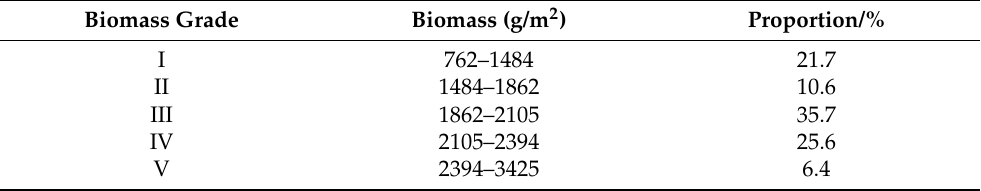
Table 5. Biomass classification of Sargassum fusiforme in the sample area based on GBDT model inversion. Biomass Grade Biomass (g/m 2 )